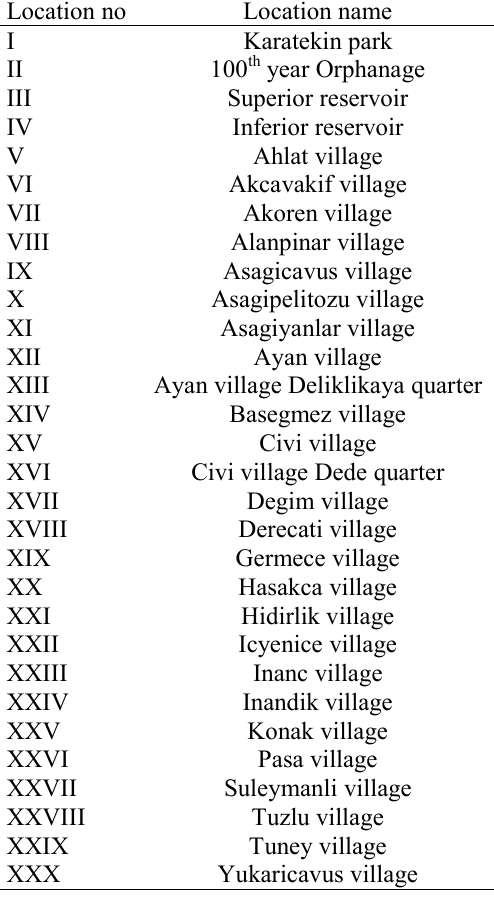
Table 1. Water sampling